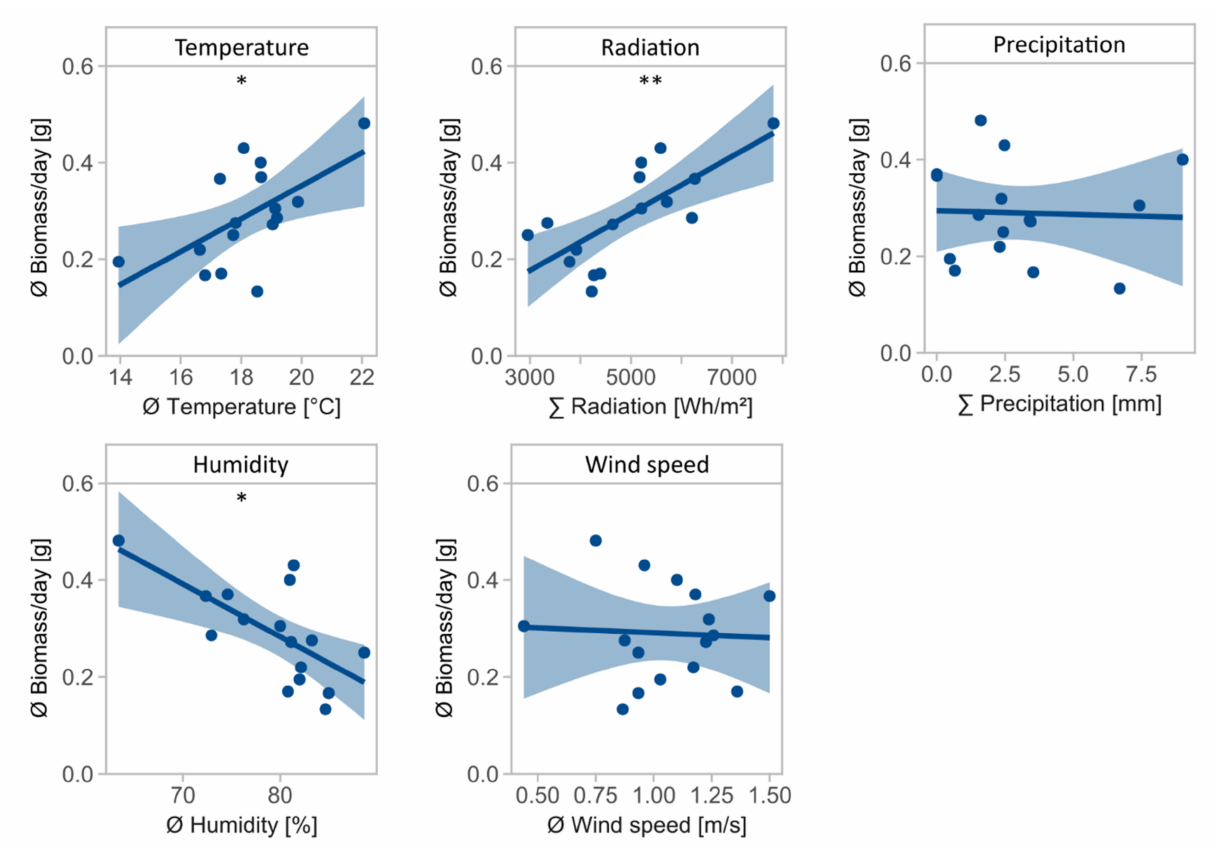
Figure 2. Mean daily biomass in g for environmental variables temperature in ◦ C, radiation in Wh/m 2 , precipitation in mm, air humidity in %, and wind speed in m/s. Asterisks indicate significant effects of environmental variables on daily biomass (significance codes: ** p < 0.01, * p < 0.05). Table 3. Number of barcode index numbers (BINs) assigned to the 1494 operational taxonomic units (OTUs) of the local and the 3245 OTUs of the regional sampling and number of families and species assigned to BINs for the most common orders. Proportion of total in % is given in brackets. Local